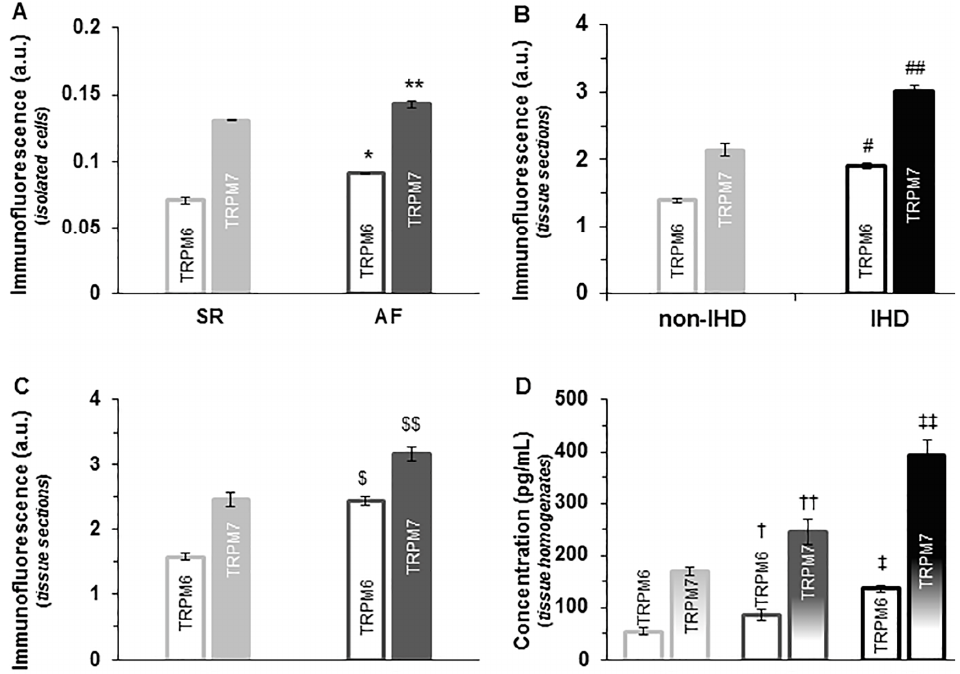
Figure 8. Effect of cardiac disease conditions on TRPM6 and TRPM7: ( A – C ) TRPM fluorescence intensity levels in RA cells ( A ) or tissues ( B , C ). Fluorescence intensity levels of TRPM6 (unfilled) and TRPM7 (filled) channels in isolated cardiomyocytes of the human heart, grouped according to the heart rhythm (SR vs. AF, ( A )) or according to the absence or presence of ischemic heart disease (non-IHD vs. IHD, ( B )). Fluorescence intensity levels of TRPM6 (unfilled) and TRPM7 (filled) channels in histological slices grouped according to the heart rhythm (SR vs. AF, ( C )); ( D ) TRPM7 and TRPM6 protein levels in human heart tissue homogenates grouped according to the heart rhythm and the presence of ischemic disease. Mean data of immunofluorescence provided in arbitrary units (a.u) for TRPM6 and TRPM7: * and ** p < 0.05 AF vs. SR, respectively, in isolated cells; # and ## p < 0.01 IHD vs. non-IHD, respectively, in tissue sections; $ and $$ p < 0.01 AF vs. SR, respectively, in tissue sections, and mean data of TRPM6 and TRPM7 protein concentrations in pg/mL, † and †† p < 0.05 AF vs. SR, ‡ and ‡‡ p < 0.05 IHD vs. SR (non-IHD), respectively.